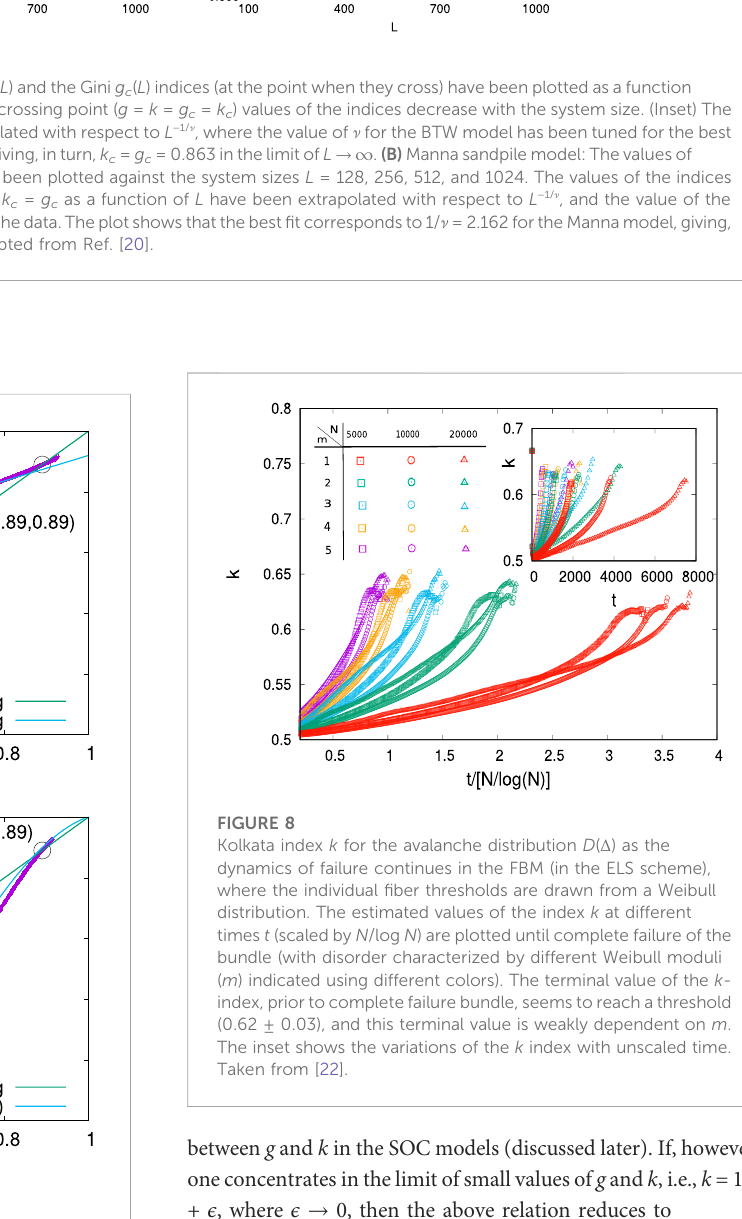
FIGURE 7 Variations of k against g indices are shown for the centrally pulled fi ber bundle model. (A) The line is a fi t for the initial growth of g and k , while the g = k line is also shown as a guide to the eye. Adapted from Ref. [20]. (B) The same variation is plotted with g against k and compared with Eq. 4.